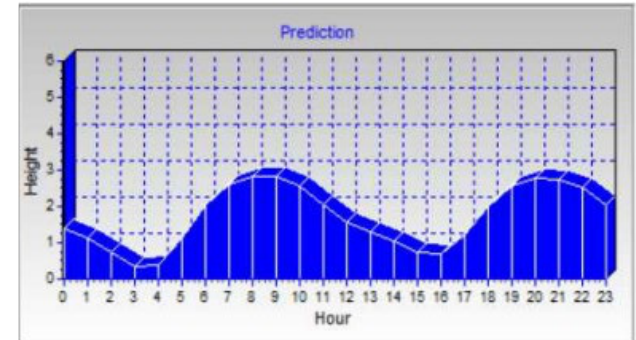
Figure 9. Prediction graph of day 1 of May 2021 in TOTIS Software